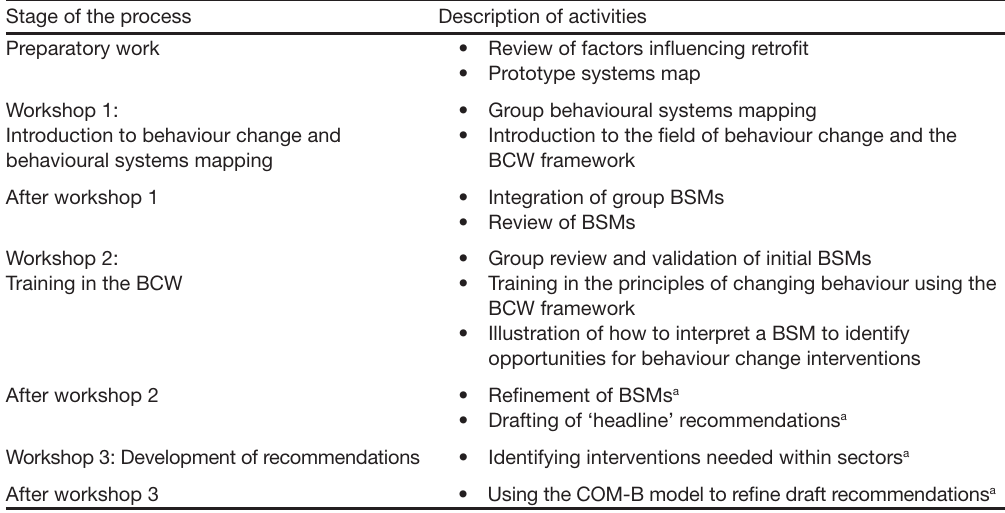
Table 1. Stages in the process of developing behaviourally-informed policy